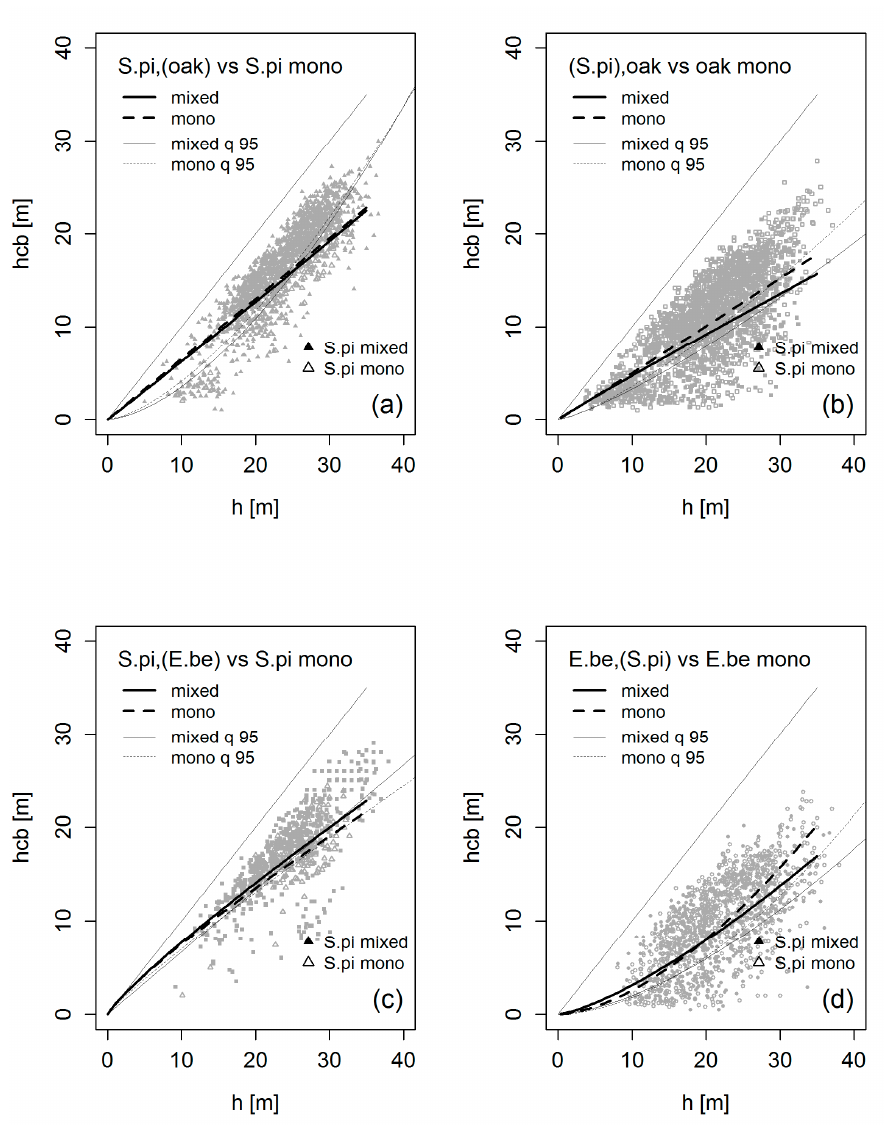
Figure 12. Height to crown base over tree height in mixed-species versus monospecific stands of ( a , b ) Scots pine and sessile / common oak and ( c , d ) Scots pine and European beech. The curves represent the mean (solid lines) and 95% quantile (thin lines) regression analyses of the hcb-h relationship. The thin bisector line indicates the minimum crown length (hcb = h). The analyses are based on crown measurement in mixed and monospecific stands across Europe (see model 7 in Table 1).